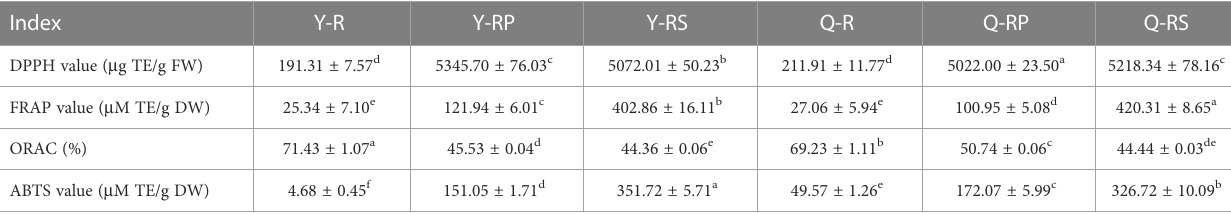
Different lowercase letters indicate signi fi cant differences at p < 0.05. FW, fresh weight; DW, dry weight. The same applies below.